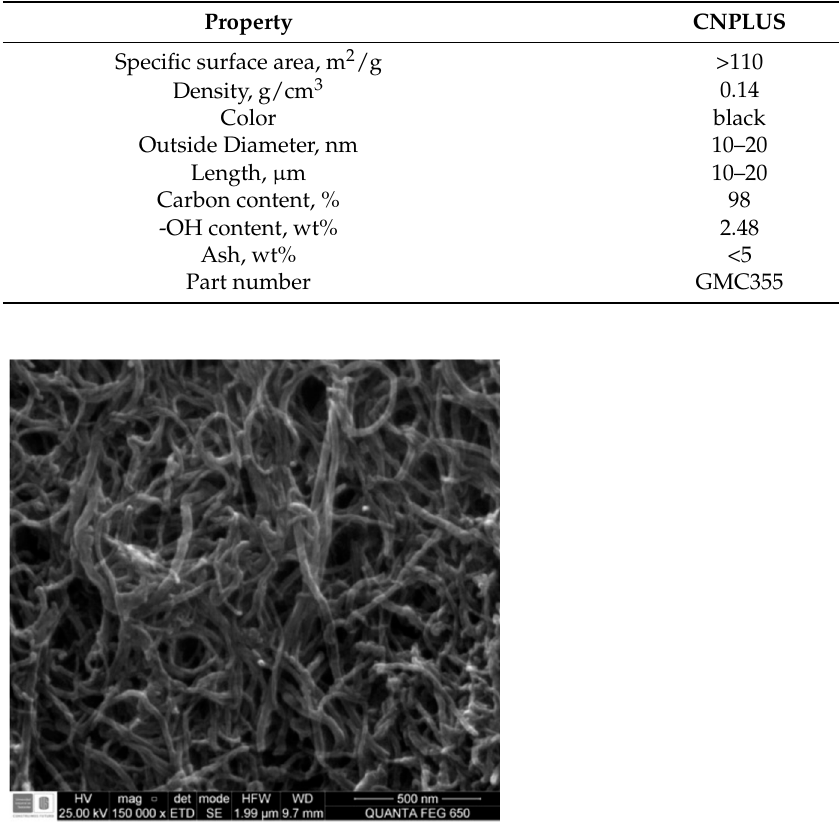
Figure 1. Morphology of the CNPLUS.